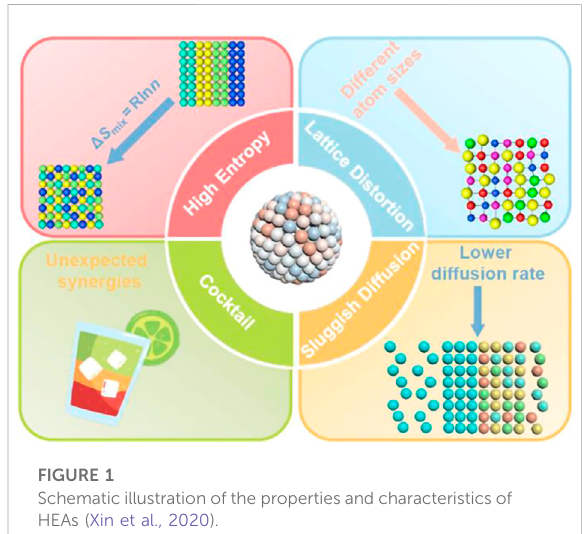
FIGURE 1 Schematic illustration of the properties and characteristics of HEAs (Xin et al.,